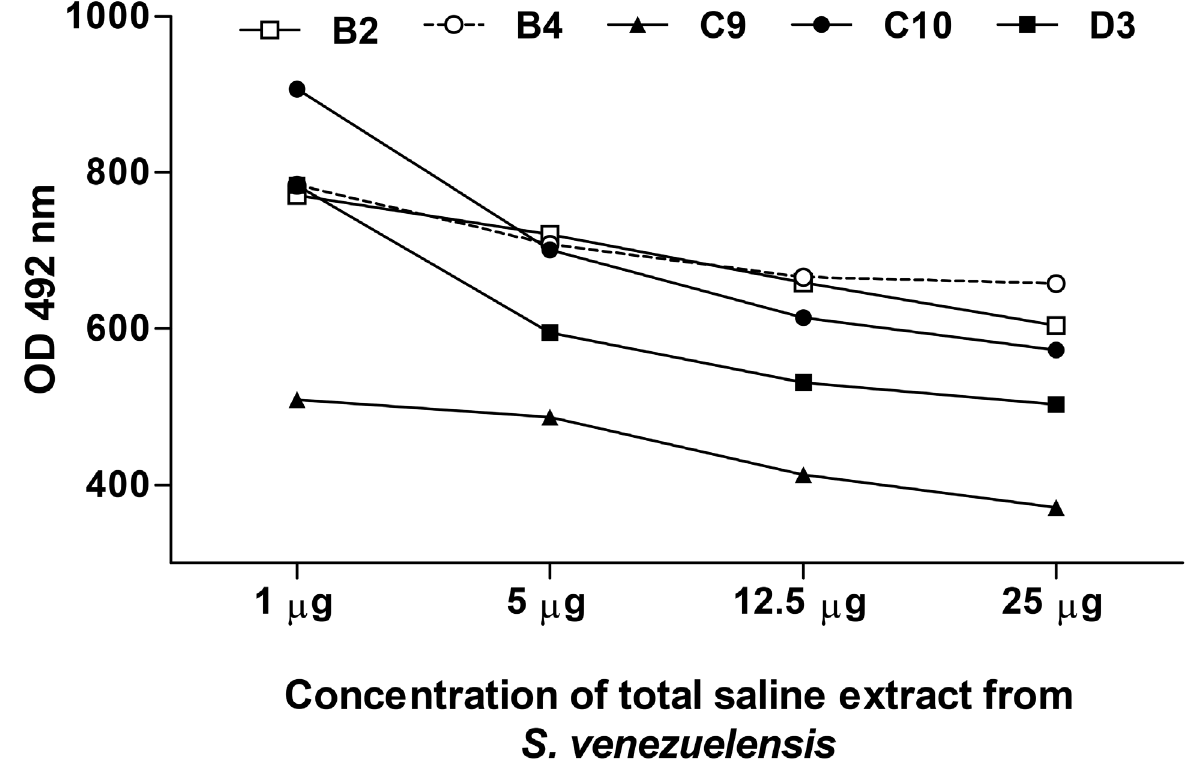
Figure 3. IgG competitive phage-ELISA assay. Plates were coated with each phage clones (1 6 10 10 pfu/mL) selected by phage display and serum samples were pre-incubated with increasing amounts (1–25 m g/mL) of saline extract from larvae of S. venezuelensis.